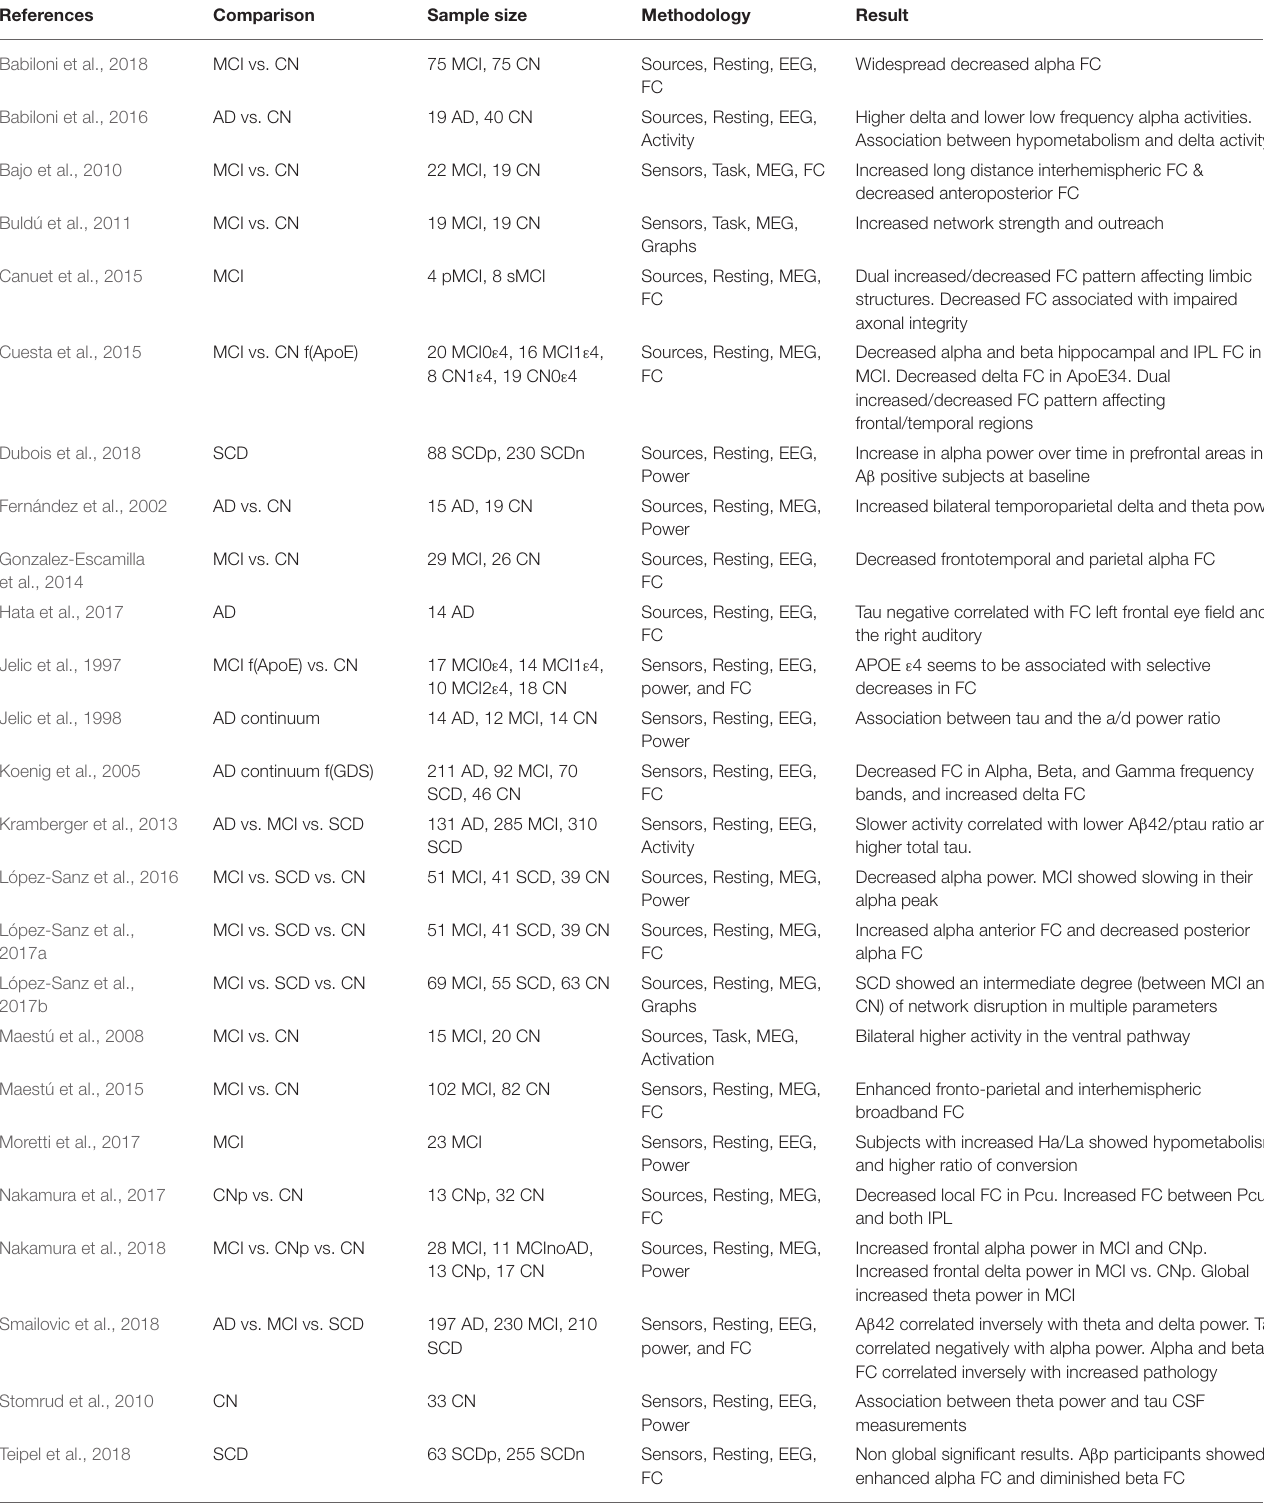
TABLE 1 | Studies of M/EEG in preclinical AD and